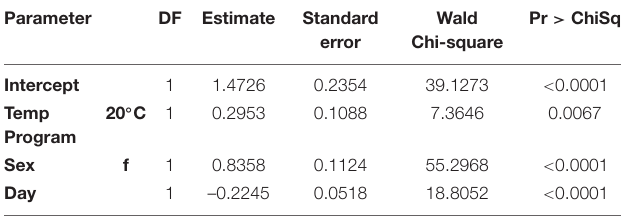
TABLE 1 | Type 3 analysis of effects for blackberry detectability over time.